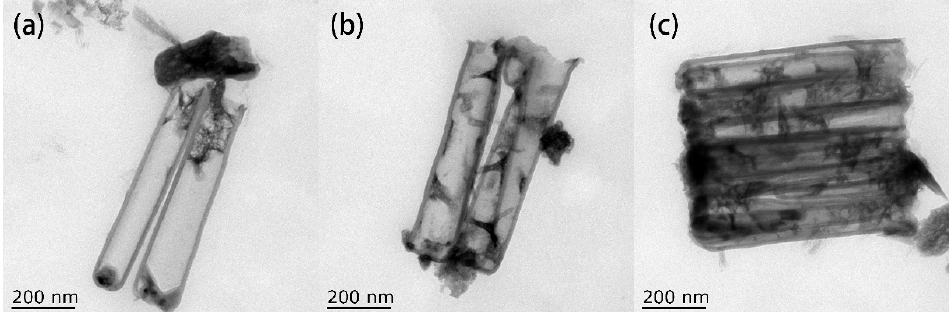
Figure 8. TEM images of copper‐filled carbon nanotubes (CNTs) with different additives: ( a ) None; ( b ) thiourea (TU); ( c ) TU and polyvinylpyrrolidone (PVP).